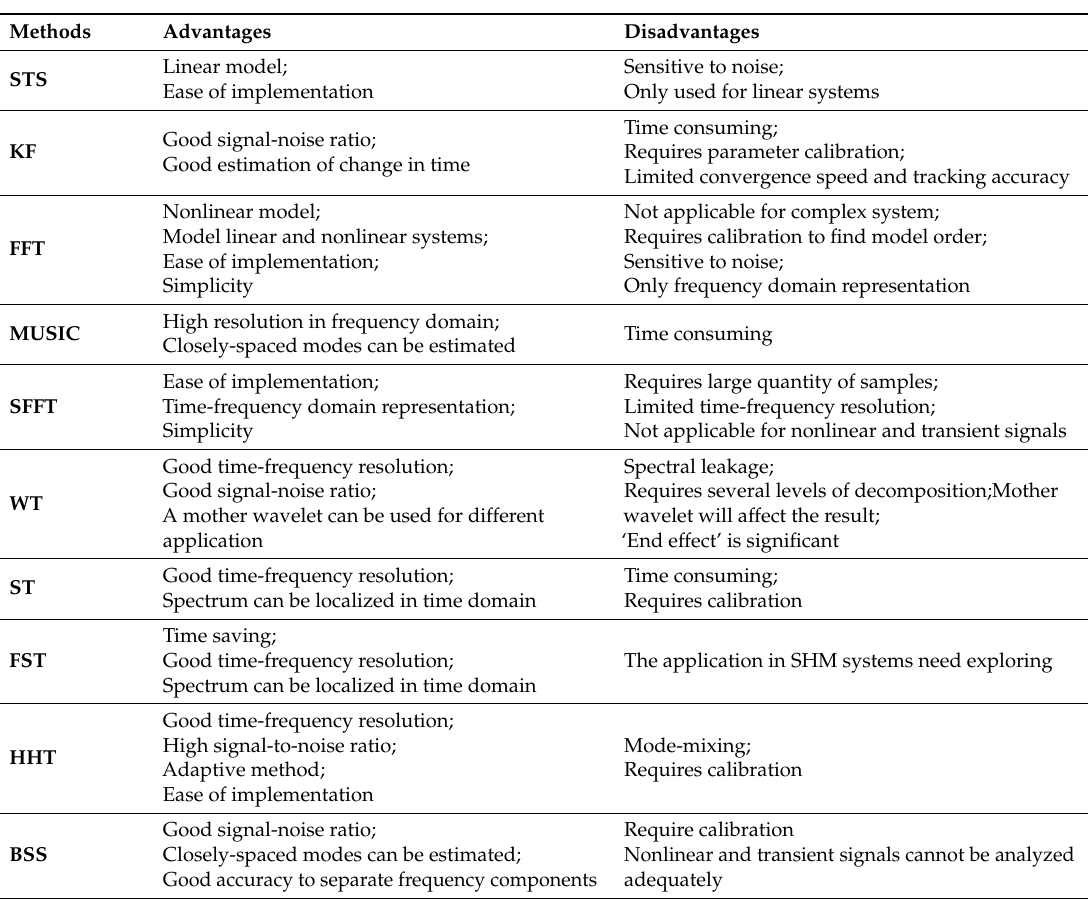
Table 2. Methods for signal processing after